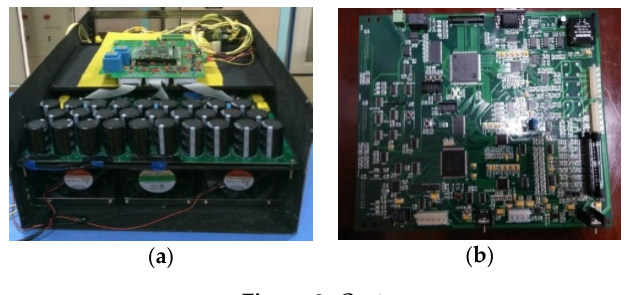
Figure 7. Simulation results of the reconfigurable inverter under faulty phase a: ( a ) output voltages; ( b ) currents; ( c ) voltage